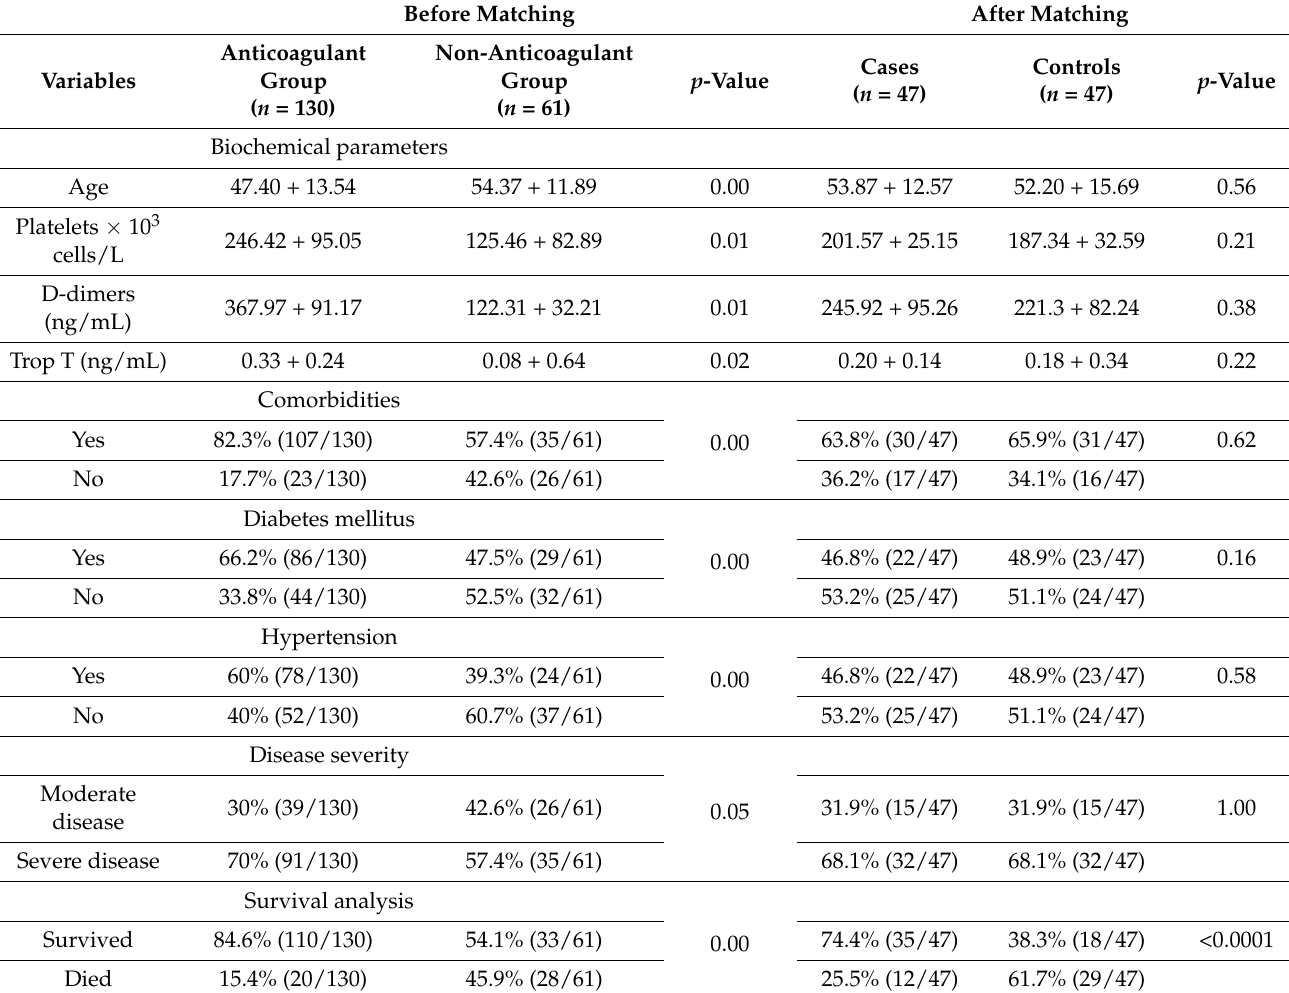
Table 1. Comparison of biochemical parameters, comorbid conditions, disease severity and survival of COVID-19 patients. Coagulant vs. non-anticoagulant group and cases vs. control in relation to p